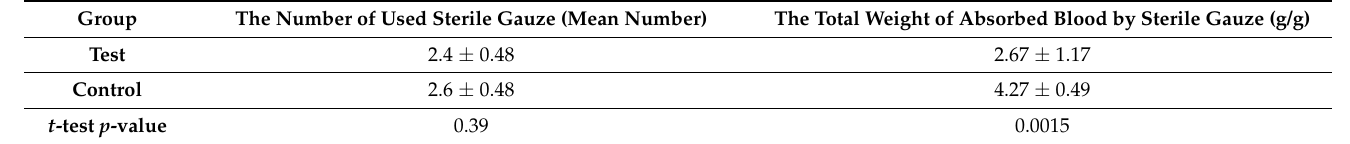
Table 3. The results of clinical assessments include the number of used sterile gas and the total weight of absorbed